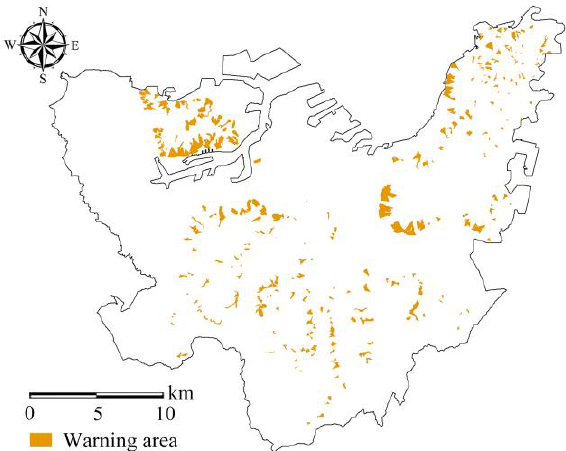
Figure 6. Warning area map of the study area after heavy rainfall.